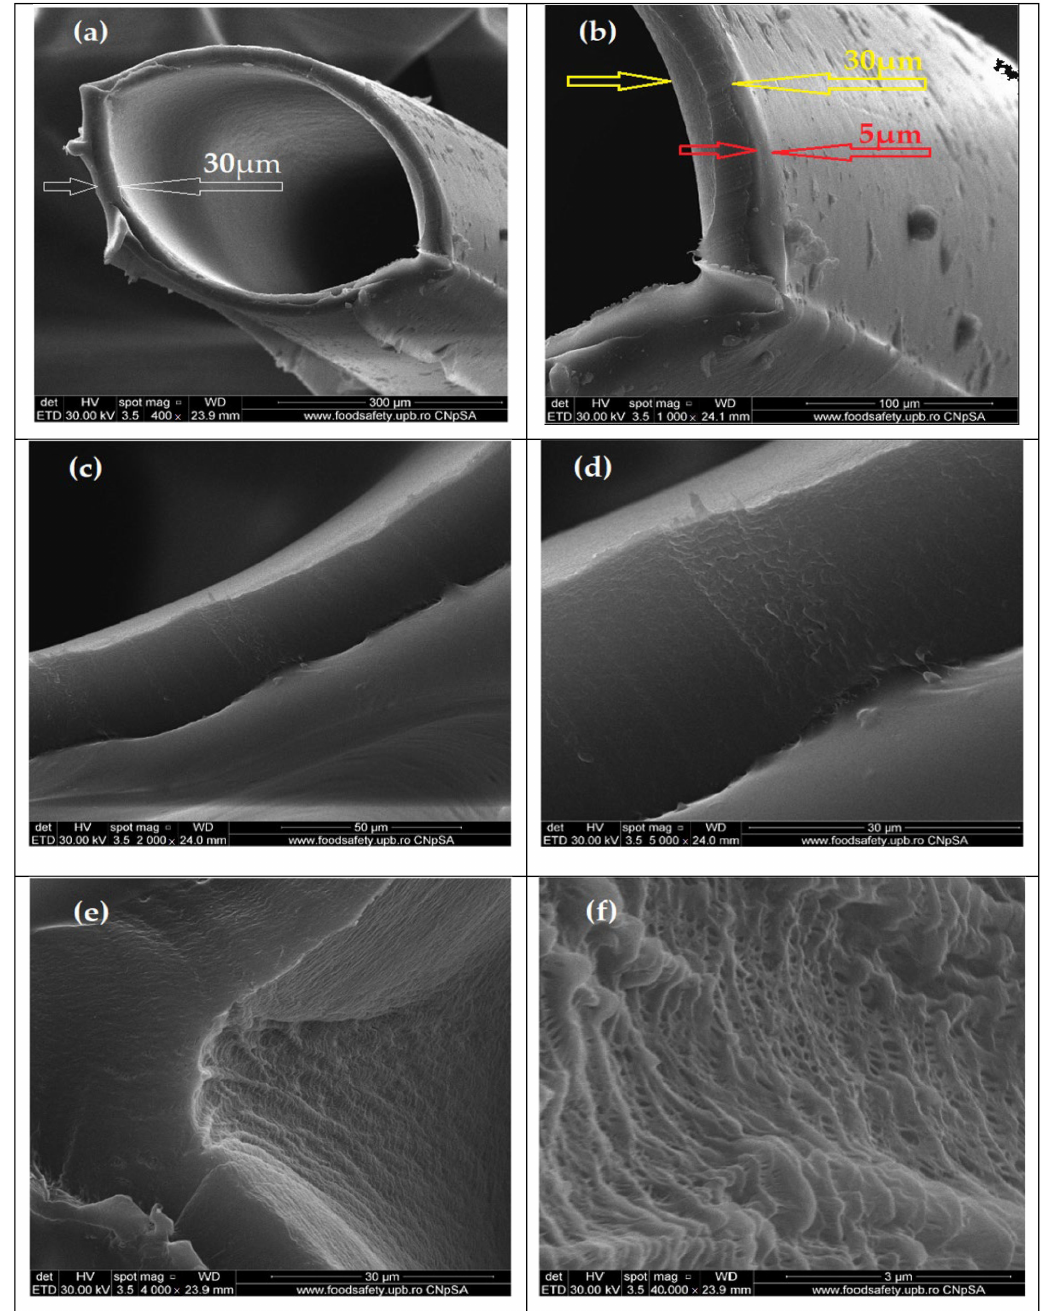
Figure 4. Scanning electron microscopy (SEM) images for the Chi/sEPDM/PPy composite mem- branes: ( a ) cross-section 400 × ; ( b ) cross-section 1000 × ; ( c ) wall detail 2000 × ; ( d ) wall detail 5000 × ; ( e ) inside aspect of wall 4000 × ; and ( f ) inside aspect of wall 40,000 ×